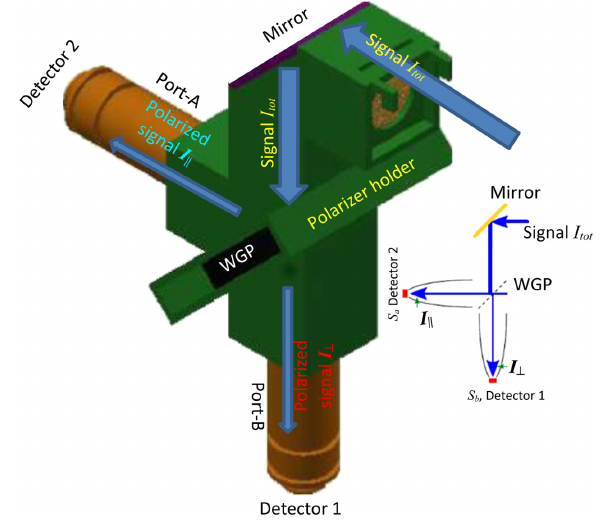
FIG. 7. Detailed technical drawing of an optical channel with all parts and the beam ray path shown. The inset is the schematic diagram of the channel in order to clarify some of the details hidden in the